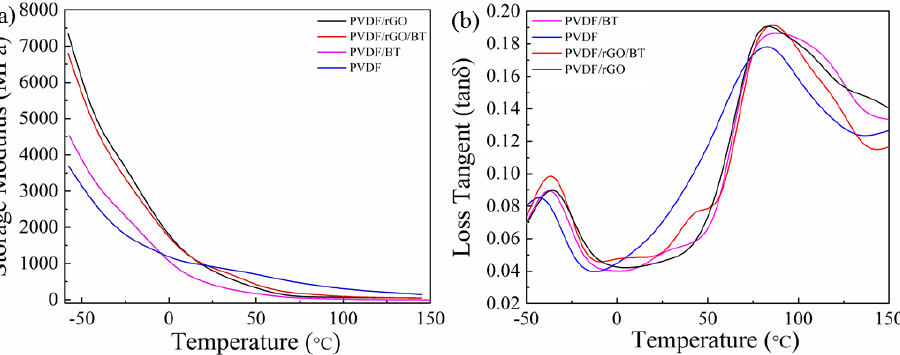
Figure 6. Dynamic mechanical analysis of the PVDF nanocomposite fibers at frequency 1 Hz: ( a ) storage modulus, ( b ) loss tangent (tan δ ).